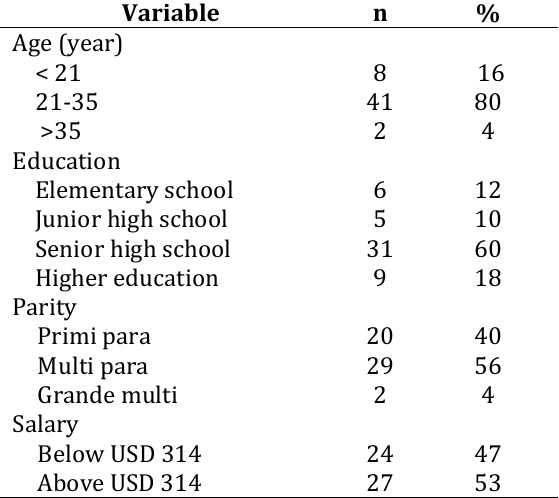
Table 1. Characteristics of pregnant women in